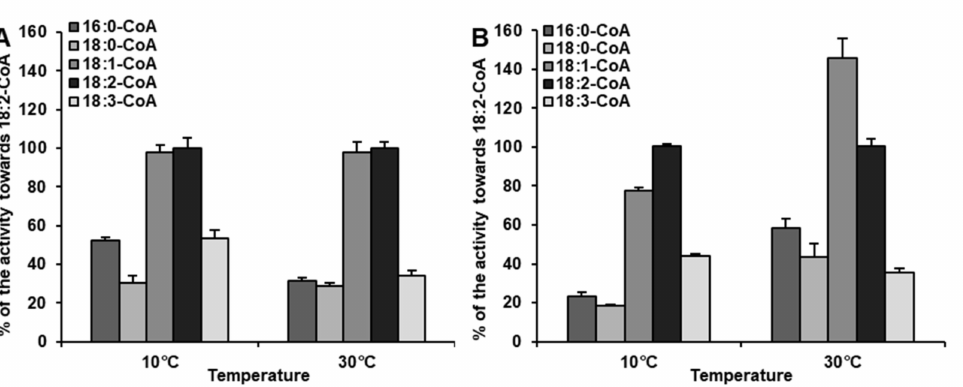
Figure 2. Activity of acyl-CoA:lysophospatidylethanolamine acyltransferases (LPEATs) present in microsomal fraction of Camelina sativa derived from in vivo ( A ) and in vitro ( B ) leaves towards five various acyl-CoAs added in equimolar concentrations with BSA into the reaction mixture. Mean values and SD are presented (data from at least three indepen- dent